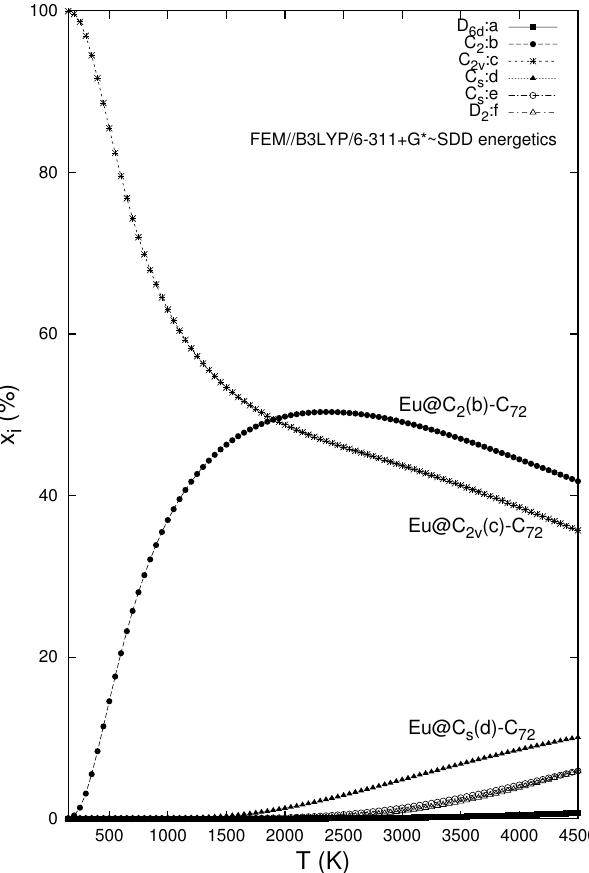
Figure 2. Relative concentrations of the Eu@C 72 isomers (see Table 1) based on the B3LYP/6-311+G* ∼